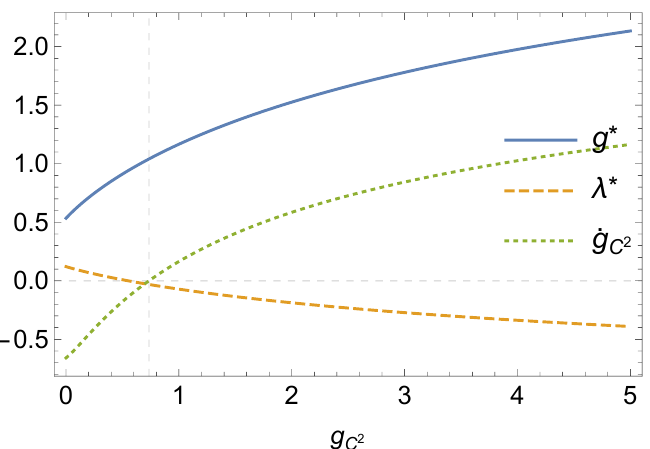
Figure 1: The partial fixed points for g (solid blue line) and λ (dashed orange line) as well as the beta function ˙ g (dotted green line) evaluated on the partial fixed C 2 point, as a function of the coupling g . The dashed grey horizontal line indicates C 2 zero, whereas the dashed grey vertical line indicates the combined fixed